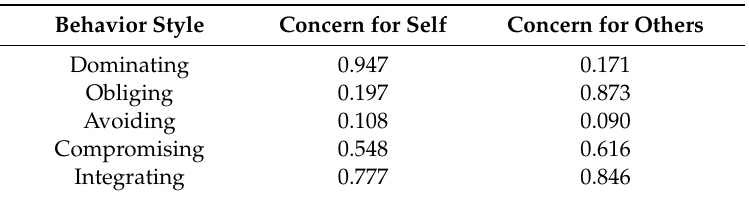
Table 2. The operating values of Concern for Self and Concern for Others for the 5 behavior style in [0, 1] interval (adapted from